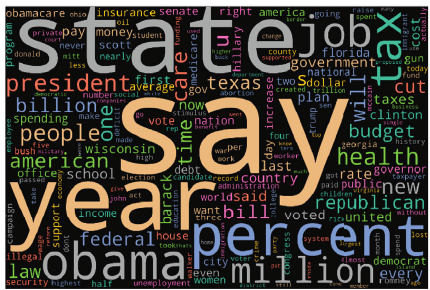
Figure 6: Word cloud after preprocessing.